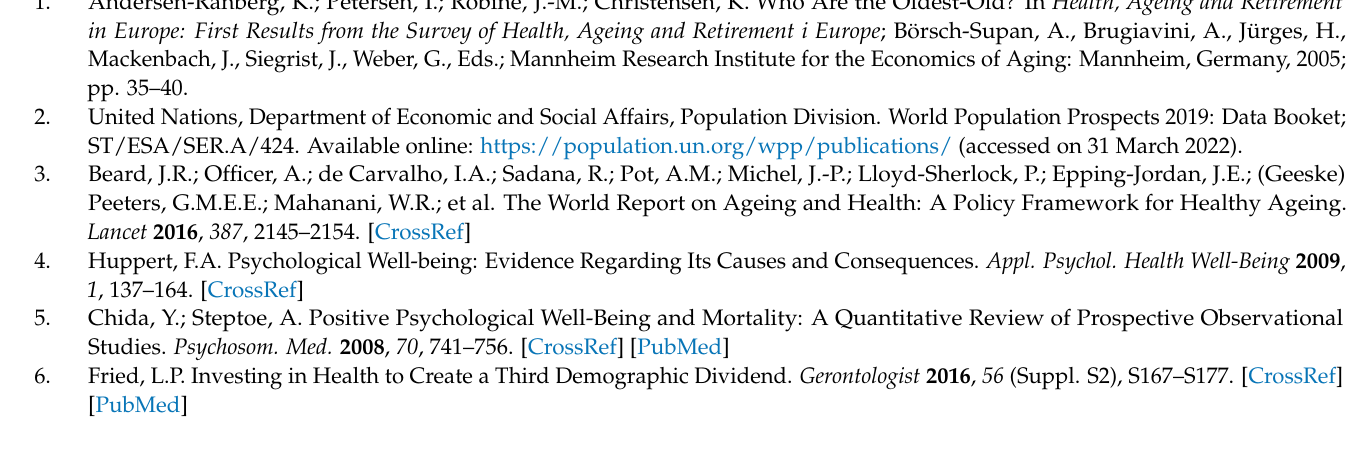
Figure A3. Place in society intervening variable: ( a ) Evaluative dimension. ( b ) Emotional dimension. ( c ) Functional dimension. ( d ) Flow dimension. ( e ) Relational dimension. Significance level denoted by stars as follows: *** p < 0.001.